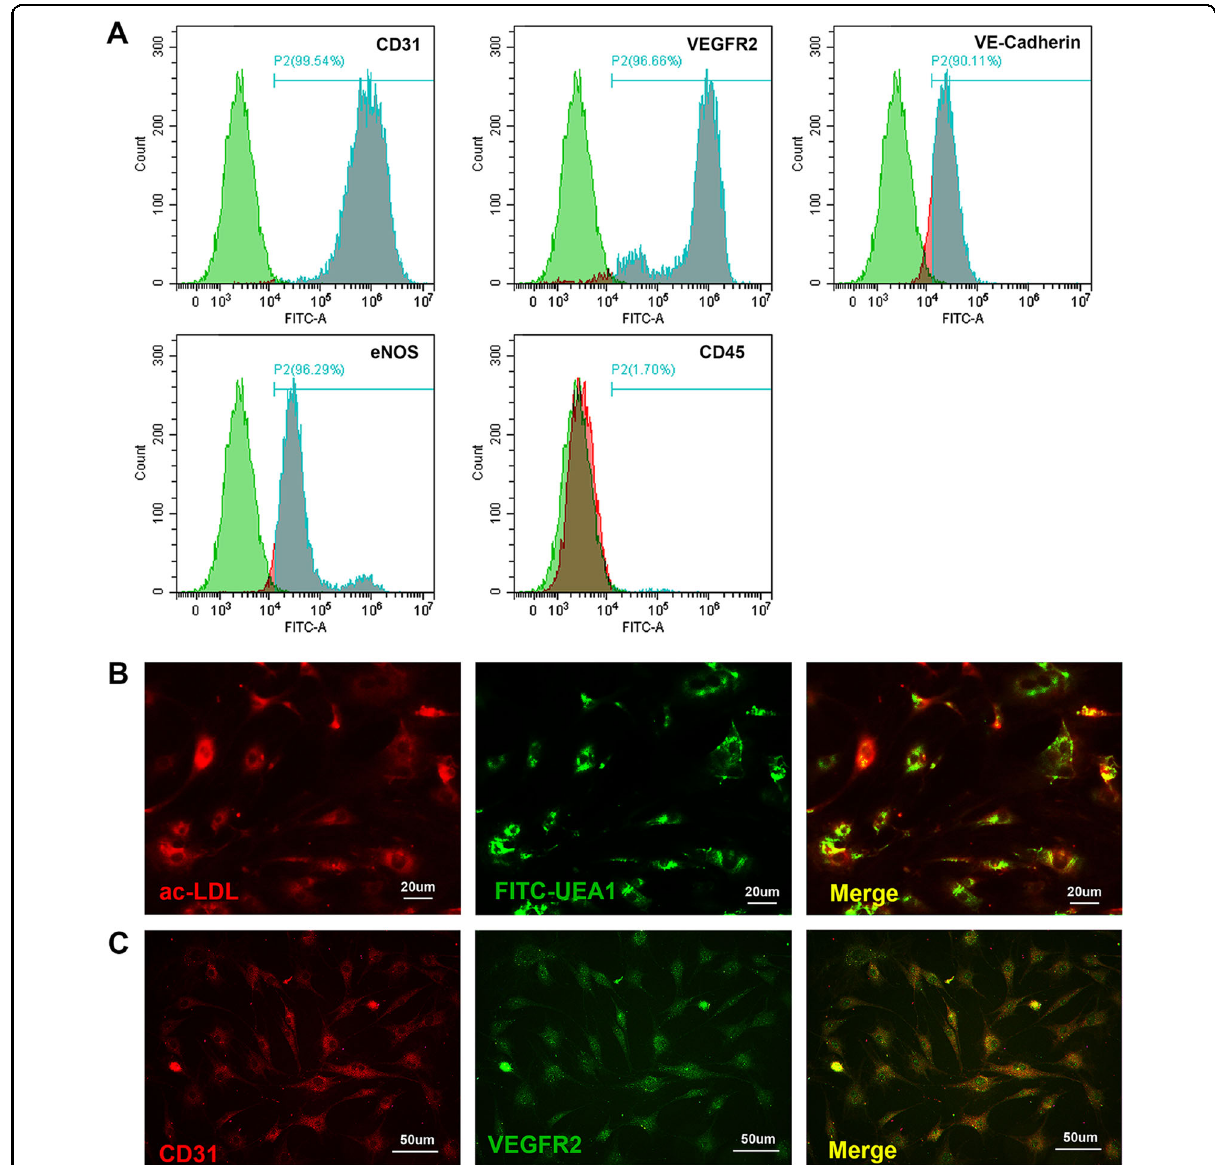
Fig. 6 Determination of the EPC phenotype. a FACS analysis was performed to assess the expression of endothelial markers in the EPC population, including CD31, VEGFR2, VE-cadherin and eNOS, as well as the monocytic marker CD45 b Fluorescent staining of double-positive cells with ac-LDL (red) uptake and FITC-UEA1 lectin binding (green) (scale bar: 20 μ m). c Immuno fl uorescence staining of CD31 (red) and VEGFR2 (green) (scale bar: 50 μ